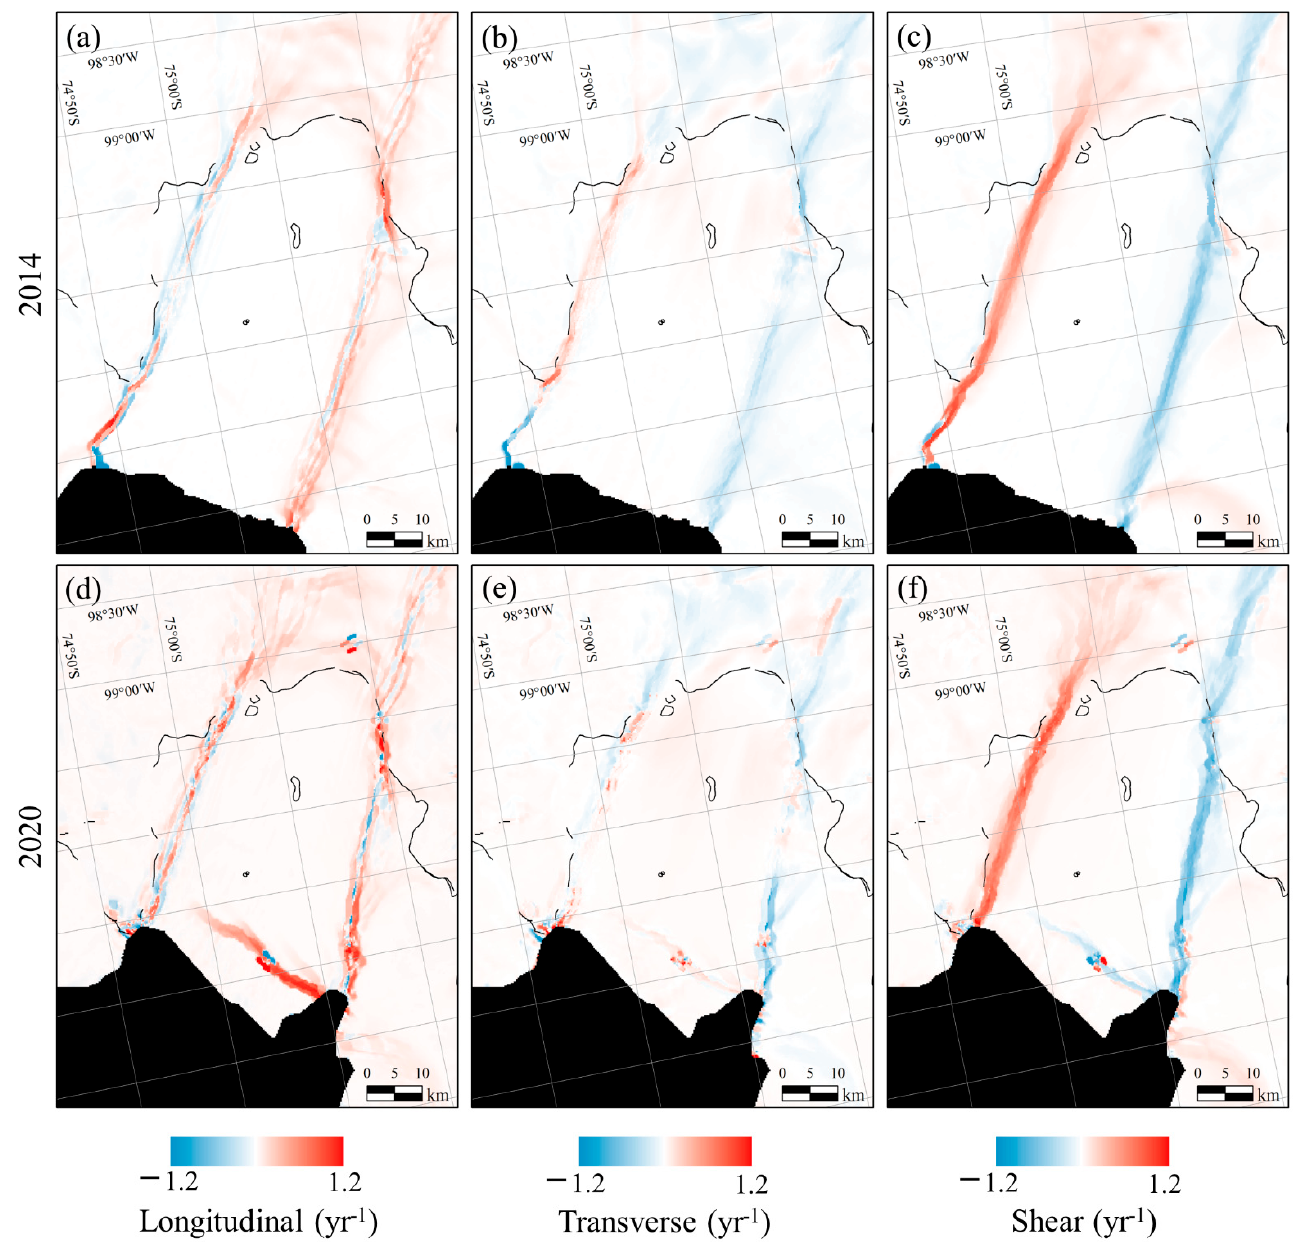
Figure 7. Surface strain rate comparison between 2014 (first row) and 2020 (second row) in PIGIS. ( a , d ) the longitudinal strain rate, ( b , e ) the transverse strain rate, and ( c , f ) the shear strain rate. The 2011 grounding line is shown as the black lines.